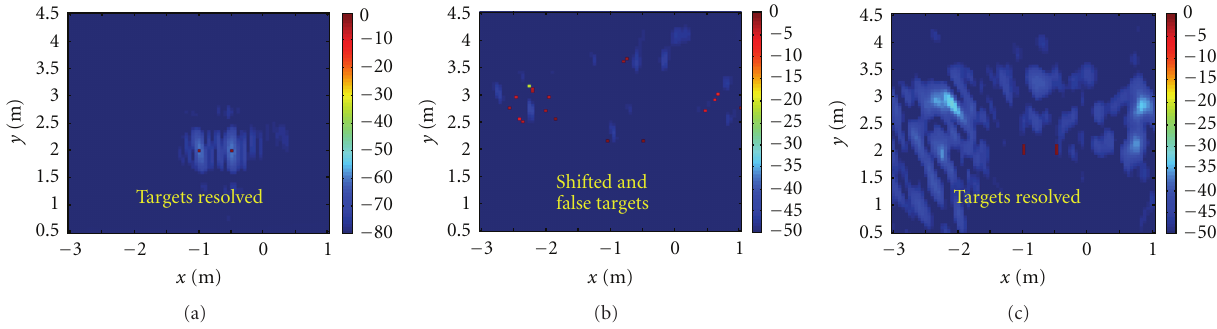
Figure 5: Sparse images ( P = 0 . 8, λ = 9,20 iterations) of the two point targets for the configuration in Figure 2 with data collected over the band 1.7–2.0 GHz: (a) image in free space, (b) image in presence of the cinderblock wall using the free space Green’s function, (c) image in presence of the cinderblock wall using the periodic layer Green’s